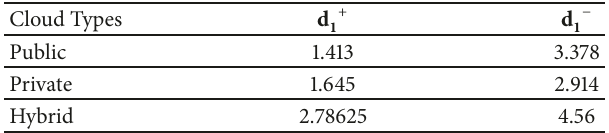
Table 7: Separation